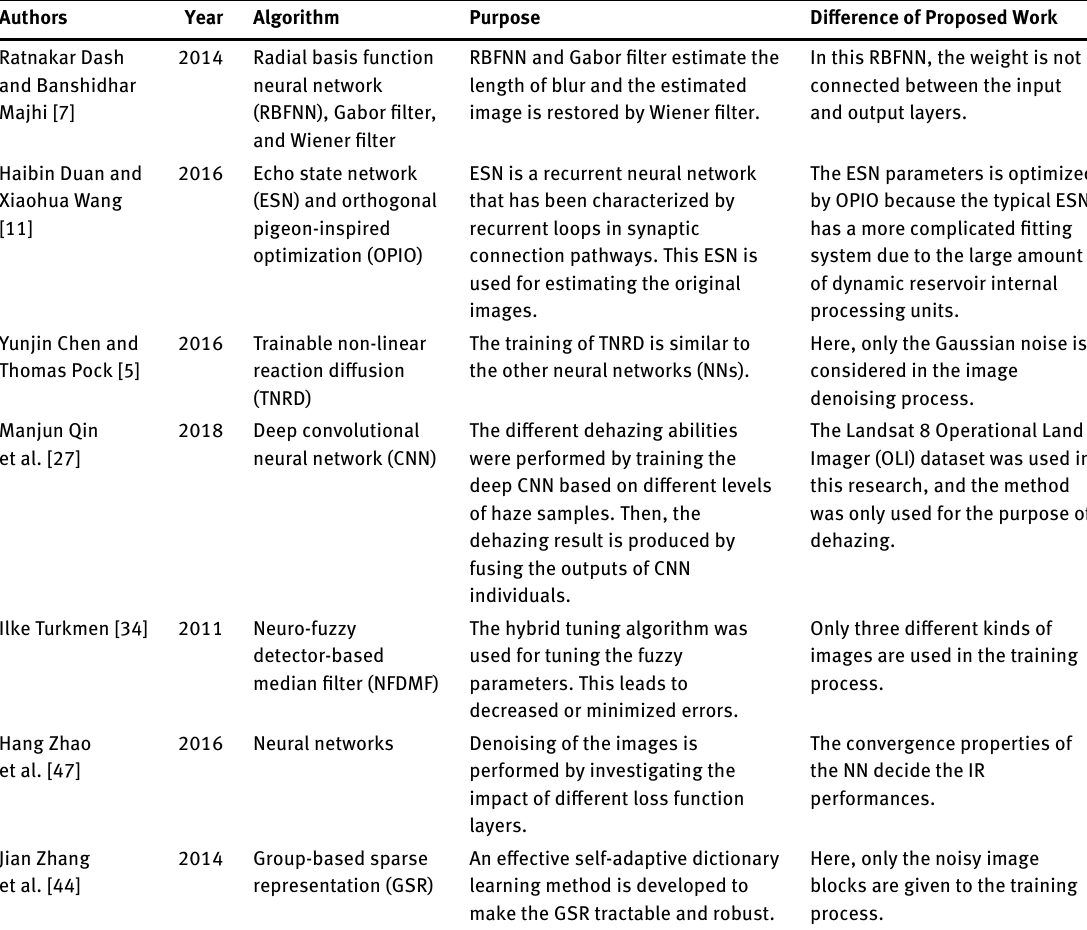
Table 1: Literature Survey.